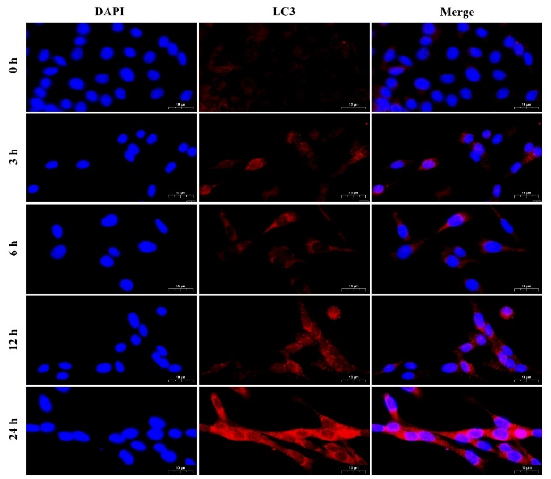
Figure 4. The fluorescence distribution of LC3 in MDBK cells after different treatment times of HG stimulation. MDBK cells were treated with 25.5 mM glucose for 0, 3, 6, 12, and 24 h, respectively. LC3 was labeled with red fluorescence by Cy3, and the nucleus was labeled with blue fluorescence by DAPI. Scale bar, 10 µm.